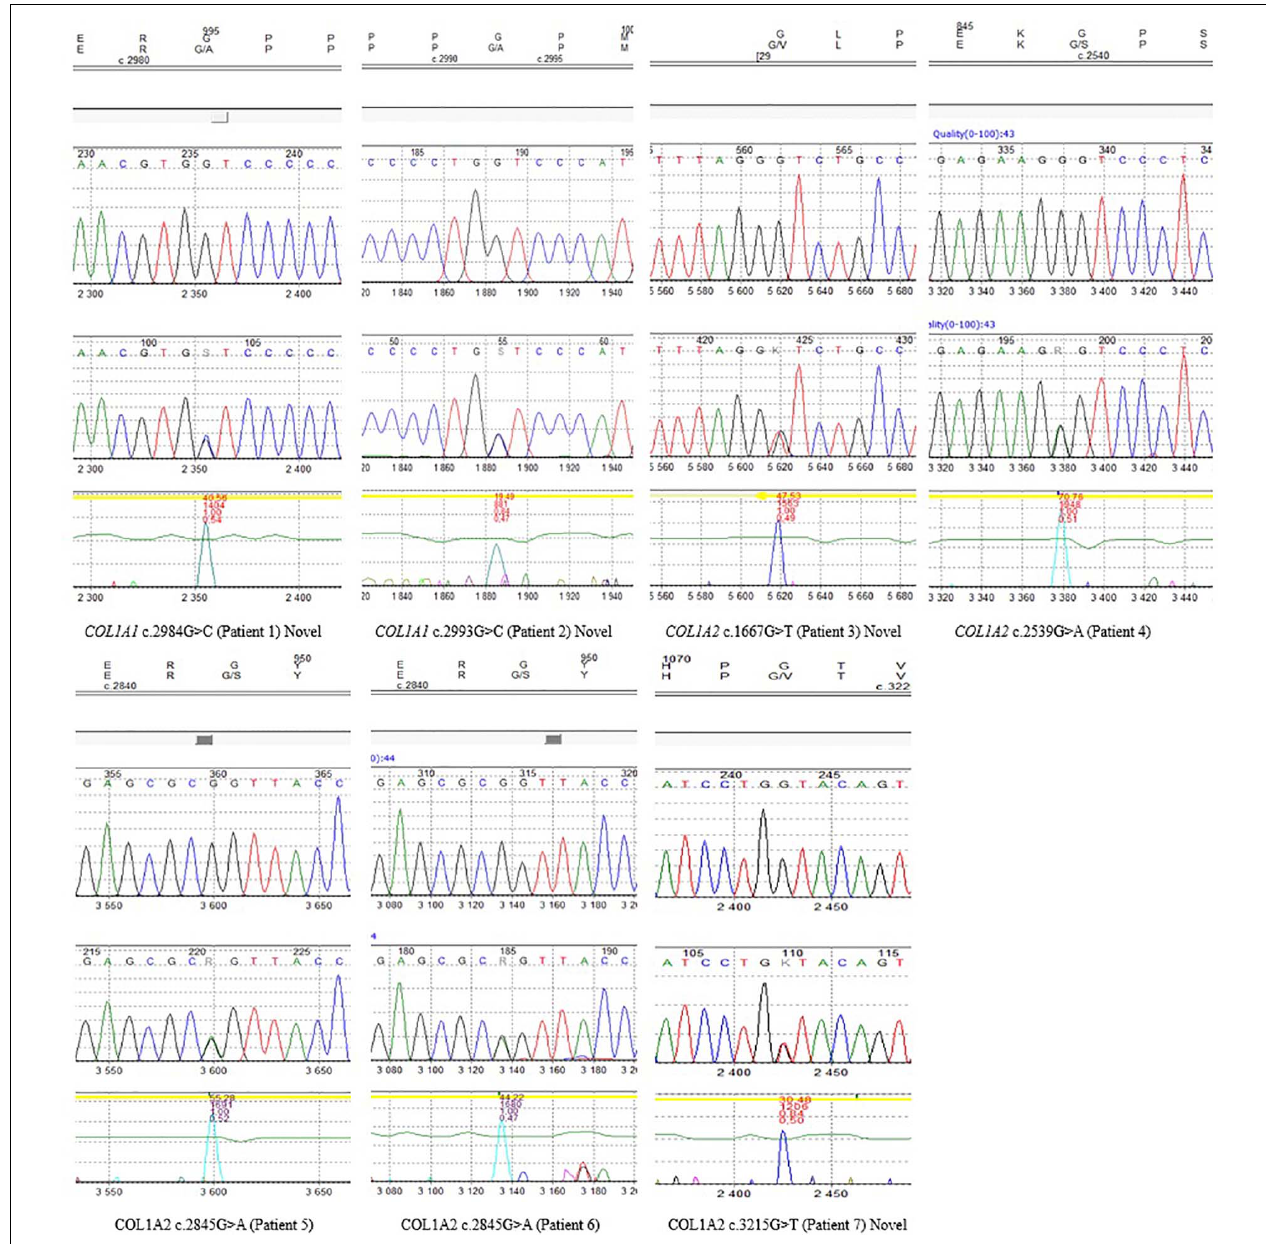
FIGURE 3 | Sanger sequencing chromatograms of all identified variants reported in seven patients, including novel